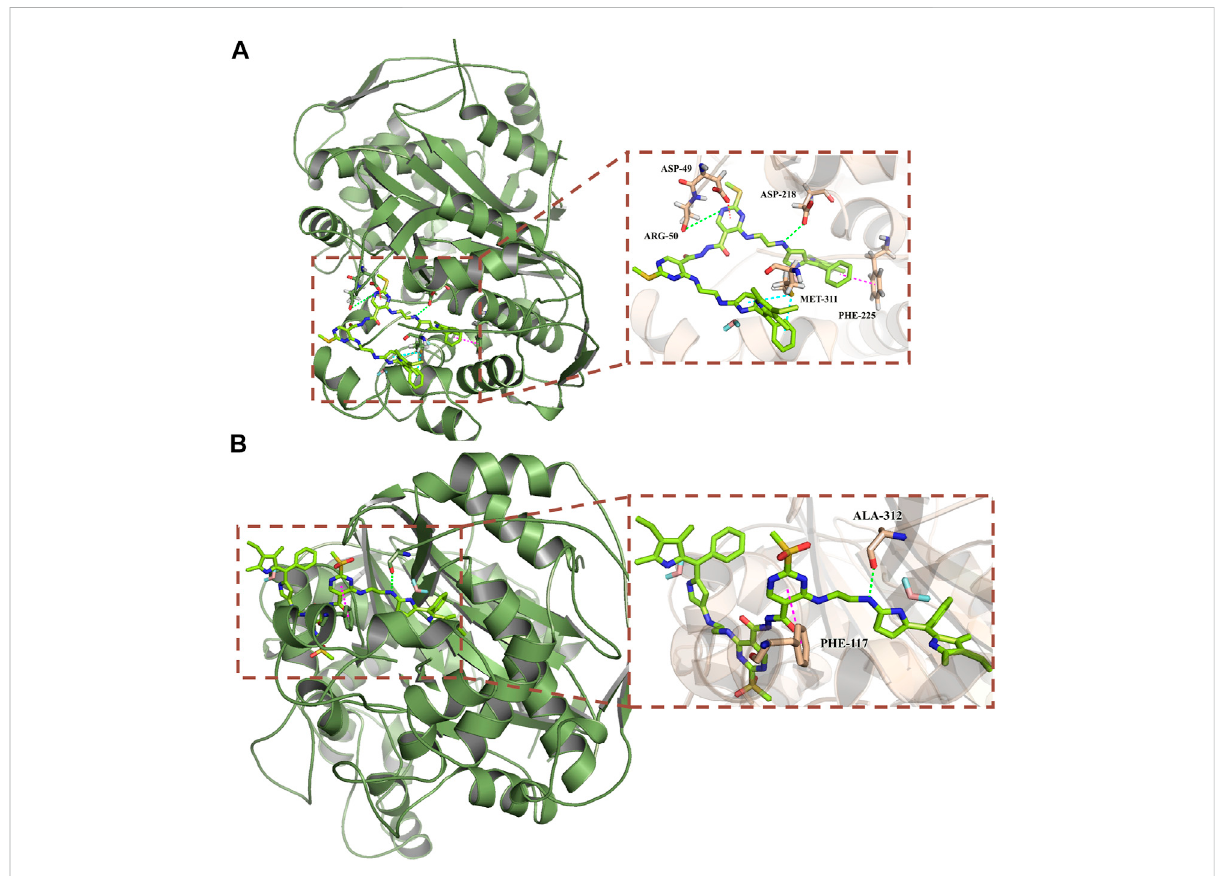
FIGURE 7 Predicted binding mode of compounds d-Y-BP (A) and dO-Y-BP (B) at the binding site of thymidylate synthase (PDB ID: